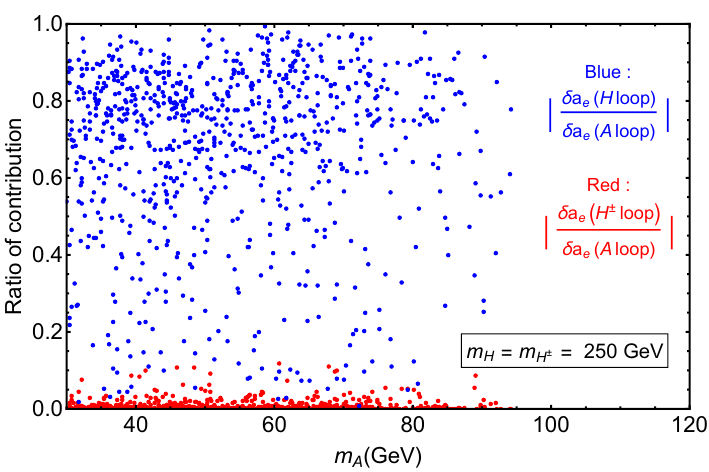
Figure 2 . Electron ( g − 2) contribution coming from the heavy neutral and charged Higgs mediated diagram relative to the pseudo-scalar mediated diagram is shown here. We have plotted the absolute value and the contribution coming from H ( H ± ) mediated diagram is opposite to(same as) the A mediated